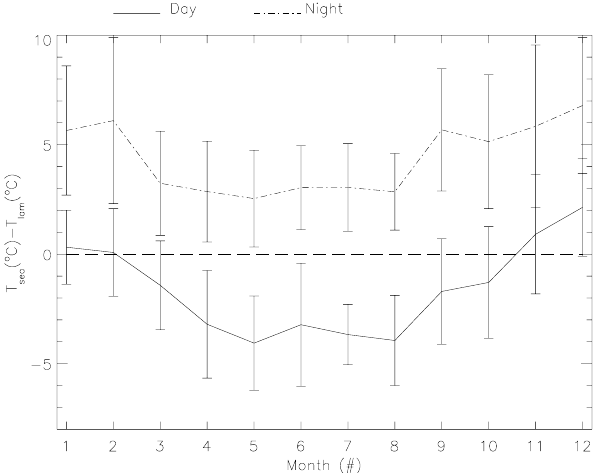
Figure 7. Monthly mean of the di ff erence between the SST of the St. Eufemia Gulf and the air temperature measured at the station during 2007–2008. Solid curve represents the temperature di ff er- ence from 11:00 to 16:00LST; dot-dash line represents the temper- ature di ff erence from 00:00 to 06:00LST. Error bars are two times the monthly standard deviation of the temperature di ff